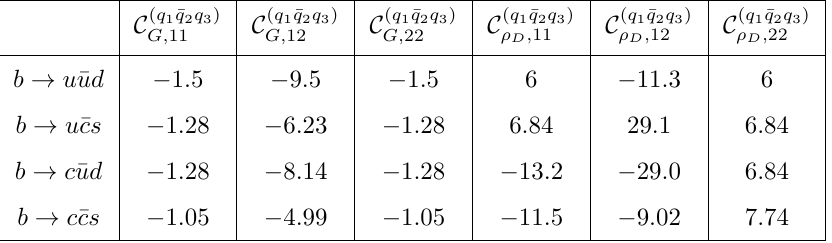
and C ( q 1 ¯ q 2 q 3 ) ρ for ρ = 0 . 05 and µ 0 = m b G,nm D ,nm